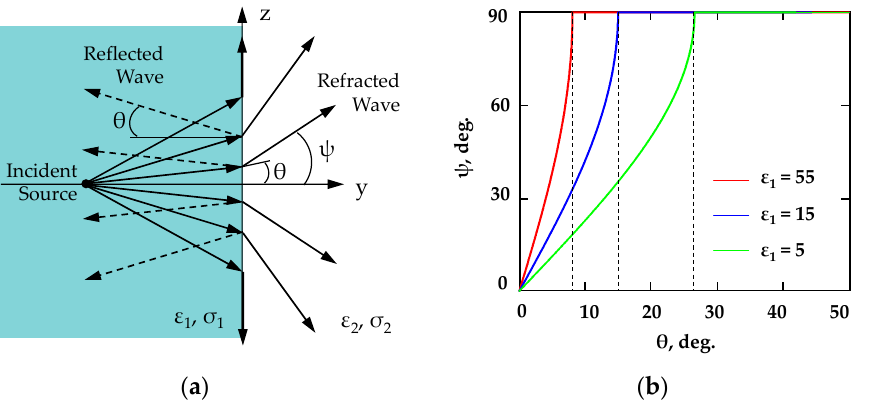
Figure 3. The spherical wave propagation across the interface between two dielectrics ( a ) and the dependence of the angle of refraction on the angle of incidence ( b ) for dielectrics with different values of permittivity ( ε 1 = 55, 15, 5) and ε 2 = 1 [13,18] .